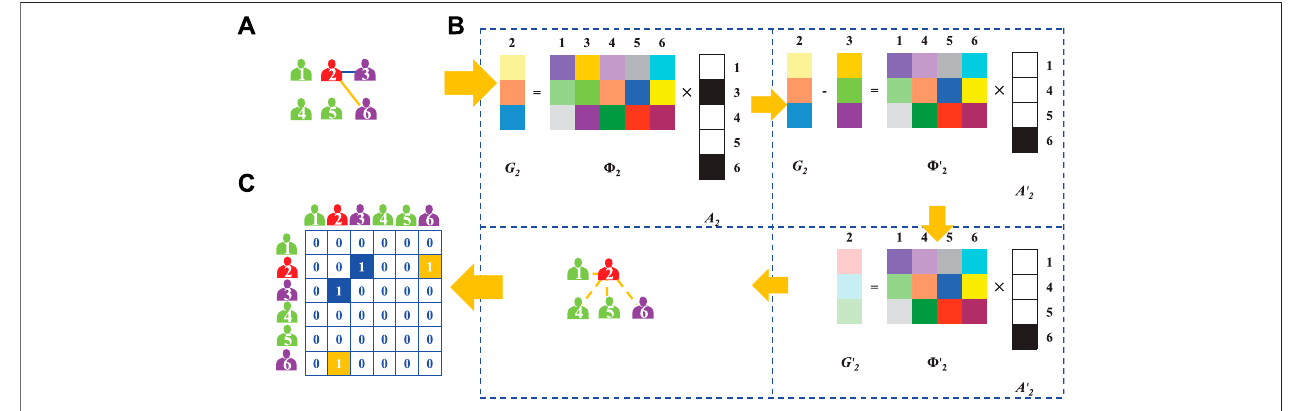
FIGURE1| (ColorOnline)Anillustrationofreconstructing thehiddenstructure ofanodebasedonprioristructure information. (A) Originaladjacentrelationshipsof anode.Foranode2inredwithtwoneighbors,node3andnode6inpurple,wecanobserveapriorirelationship,representedwithablueline,betweennode2andnode 3. (B) EEM. We establish vector G 2 and matrix Φ 2 in the reconstruction form G 2 (cid:1) Φ 2 · A 2 from time-series information, where vector A 2 captures the adjacent relationshipsbetweennode2andtheothernodes.Aftersubtractingtime-seriesinformationdeterminedbynode2andpriorineighbor,node3,onthebothsidesof theequation,theunknownconnectionsofnode2canbereconstructedbyoptimizingthesolutionofthefollowingequation G 2 ′ (cid:1) Φ 2 ′ · A 2 ′ usingEEM. (C) Areconstructed adjacent matrix. The unknown neighbors of node 2 could be uncovered by EEM. The adjacent matrix is presented, in which golden blocks represent reconstructed link.